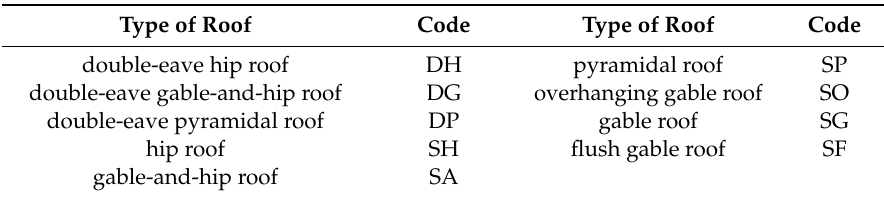
Figure 5. The codes of roof decorative components. Table 4. Design of rigid